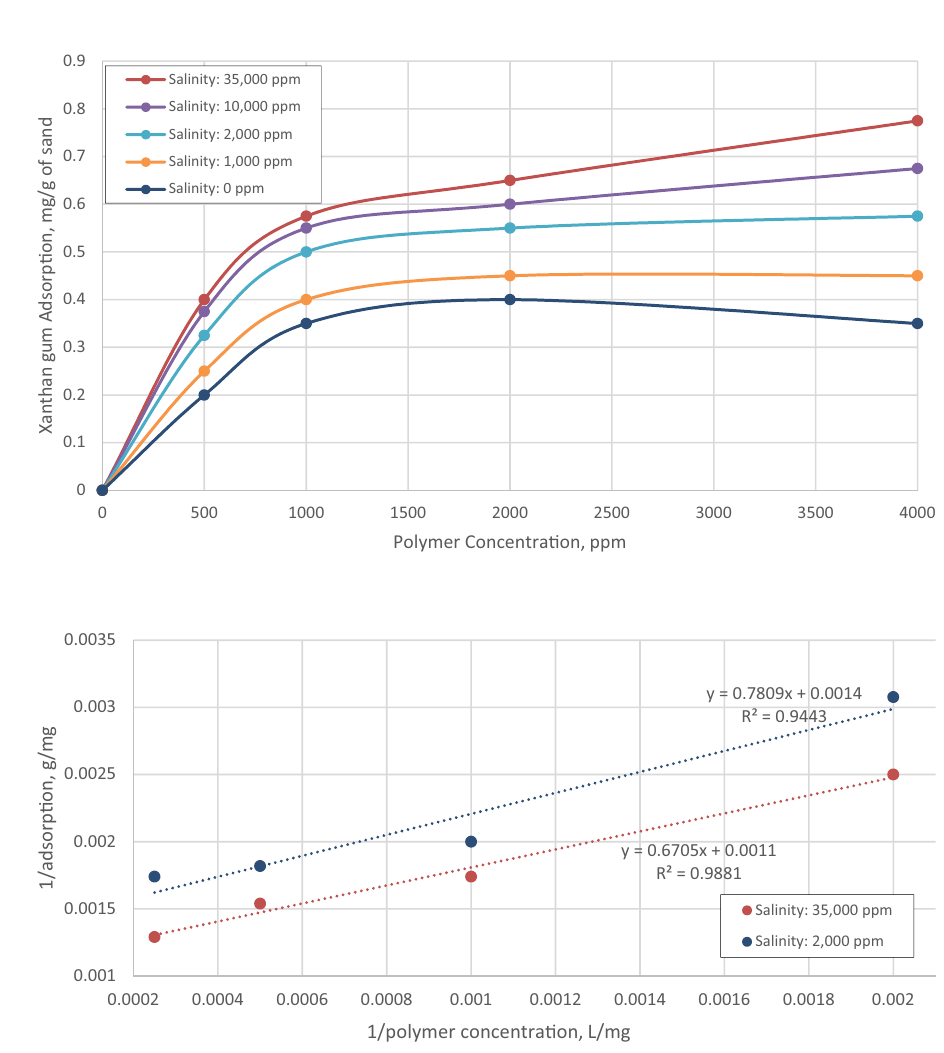
and Flori (2018). The results obtained for the 1000 ppm xanthan gum sample containing 0 ppm NaCl were used in the fine-tuning the gel slug model, those for the 2000 ppm